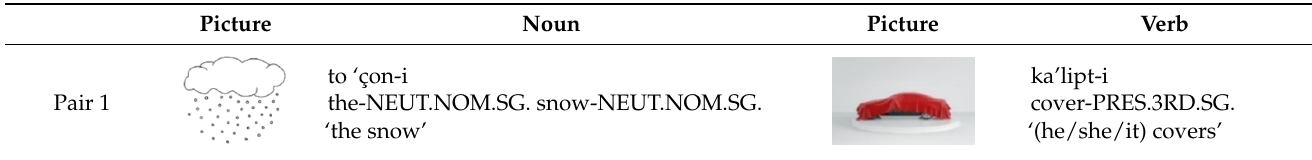
Table 1. Example material for the flashcards intervention.